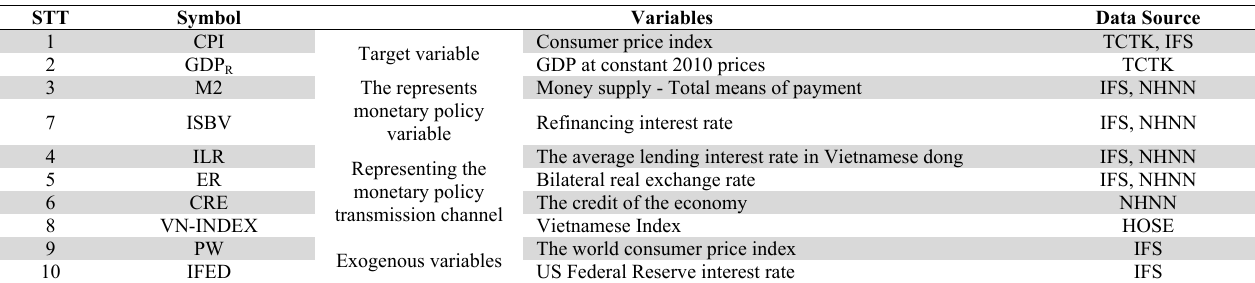
Variables in the VECM model